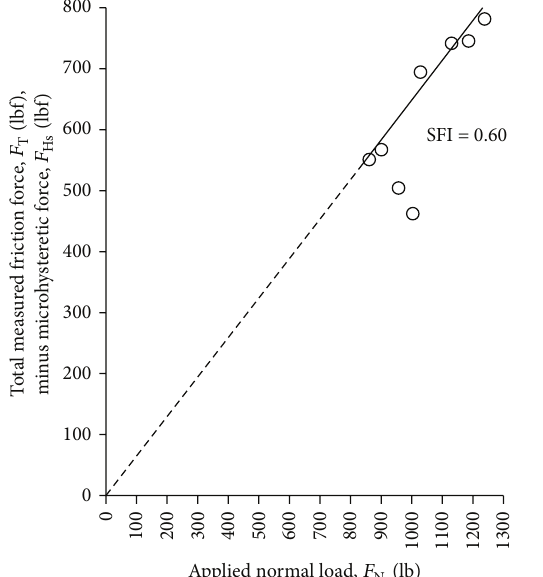
Figure 18: Dry Belcher Road test results showing the sliding friction index (SFI) value.